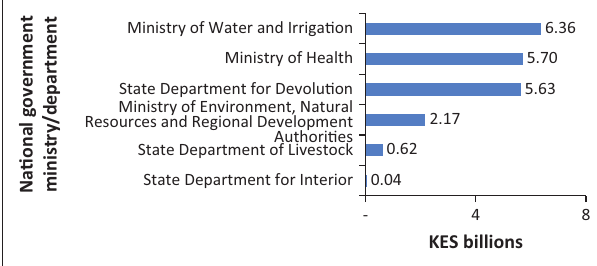
FIGURE 3: Domestic funding to disaster preparedness financial year 2016–2017.